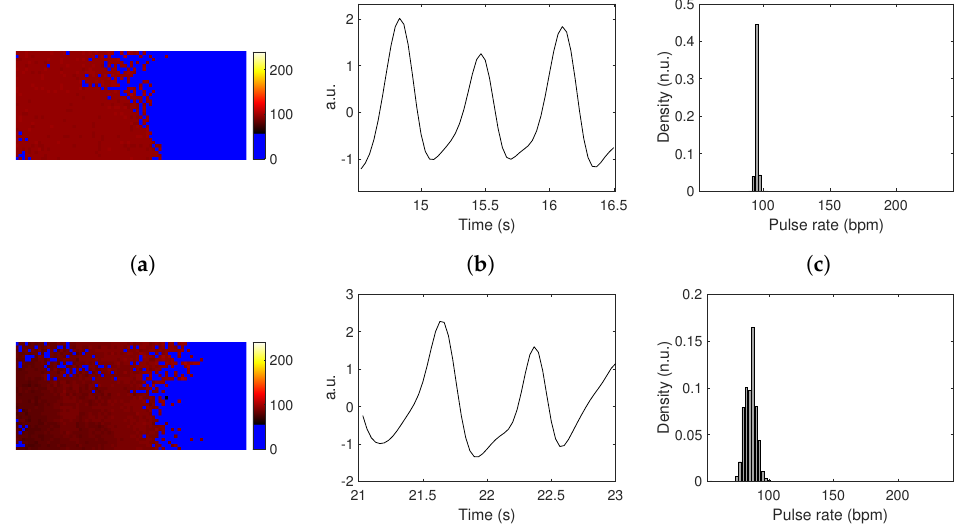
Figure 12. Impact of a non-stationary signal on its relative histogram of predictions. ( a ) Prediction maps from subject #40 (region of interest: forehead). ( b ) PPG signals computed with the GREEN method. ( c ) histograms of predictions. Top row: The frequency of the PPG signal is quite constant. Bottom row: the frequency of the PPG signal rises as time